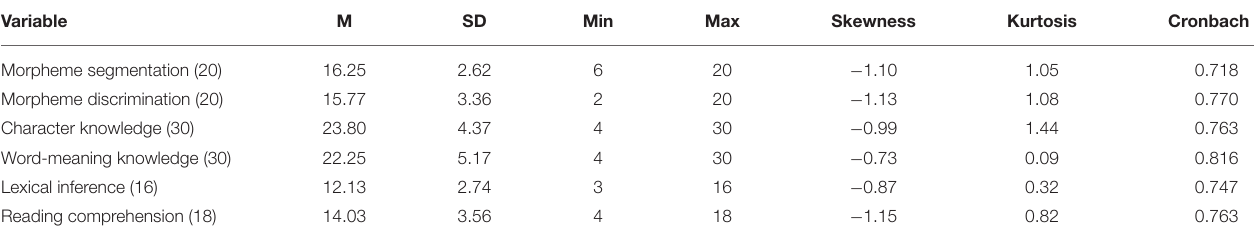
TABLE 1 | Descriptive statistics of morphological awareness, vocabulary knowledge, lexical inference, and reading comprehension. Variable M